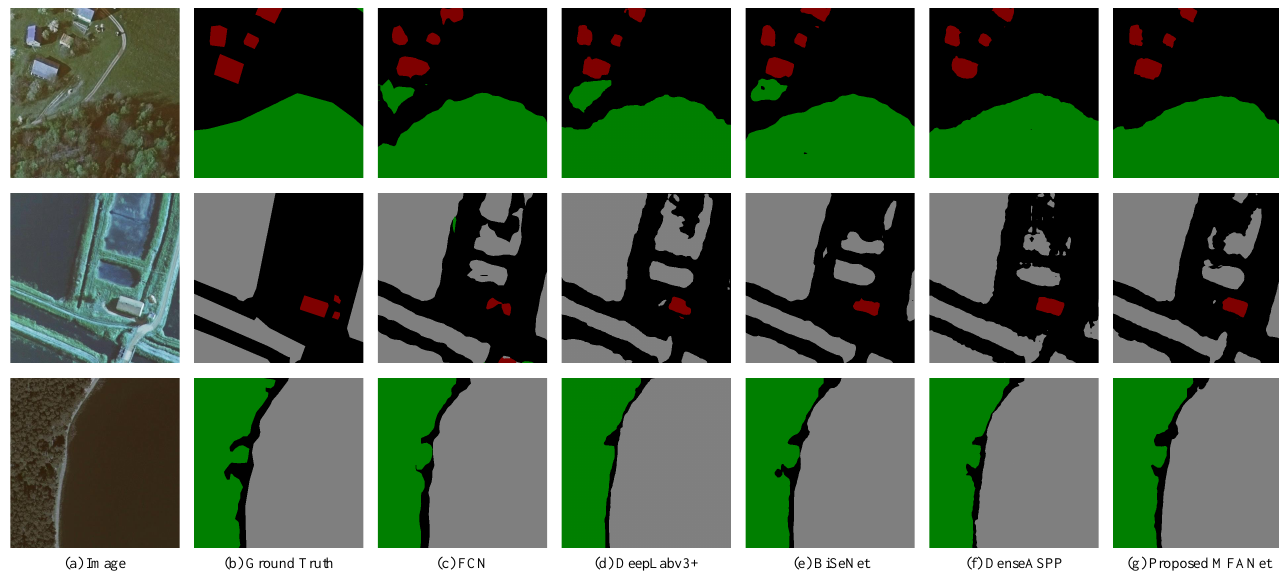
Figure 7. Prediction results of images with three classifications.( a ) The original images; ( b ) Corresponding labels; ( c ) The predicted maps of FCN; ( d ) The predicted maps of DeepLabv3+; ( e ) The predicted maps of BiSeNet; ( f ) The predicted maps of DenseASPP; ( g ) The predicted maps of proposed MFANet.